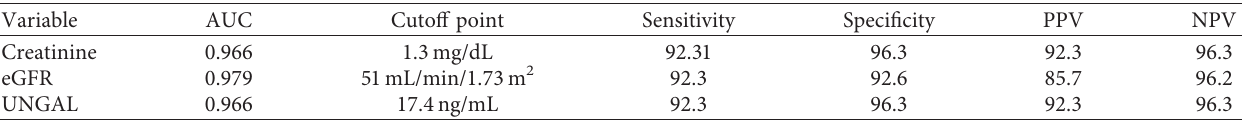
Table 7: Cutoff levels for three-month follow-up UNGAL and conventional biomarkers in predicting renal response to induction. Variable AUC Cutoff point Sensitivity Specificity PPV NPV Creatinine 0.966 eGFR